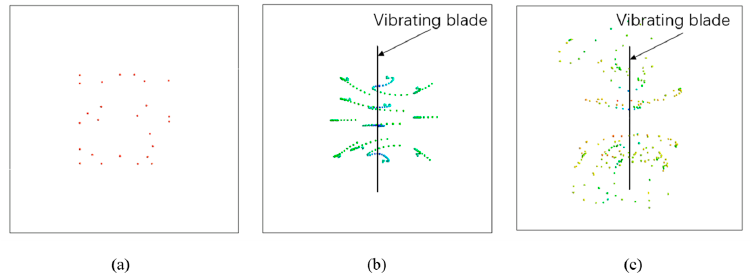
Figure 11. Poincar é map for different frequencies: ( a ) without blade; ( b ) f = 5 Hz; ( c ) f = 10 Hz.